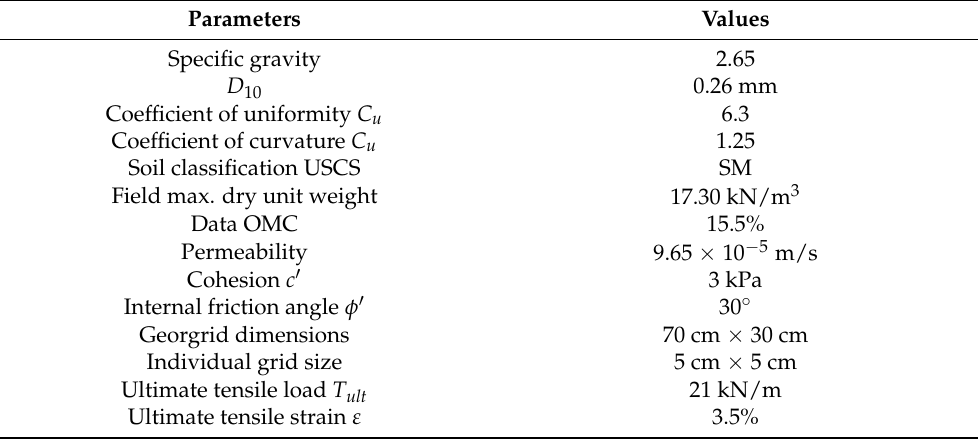
Figure 1. Actual and conceptual model of the test setup of a pullout machine and sensors installed. Vertical stresses of around 25 kPa, 60 kPa, and 100 kPa are applied with a degree of saturation of about 90%, 80%, 70%, and 45%. The controller of the machine has the capability to regulate the loading rate which is set to 1.0 mm/min (ASTM standard D: 5321). ( a ) The laboratory experimental setup. ( b ) Sensors installed inside and outside of the pullout box. Table 1. Geotechnical properties of soil and geogrid.